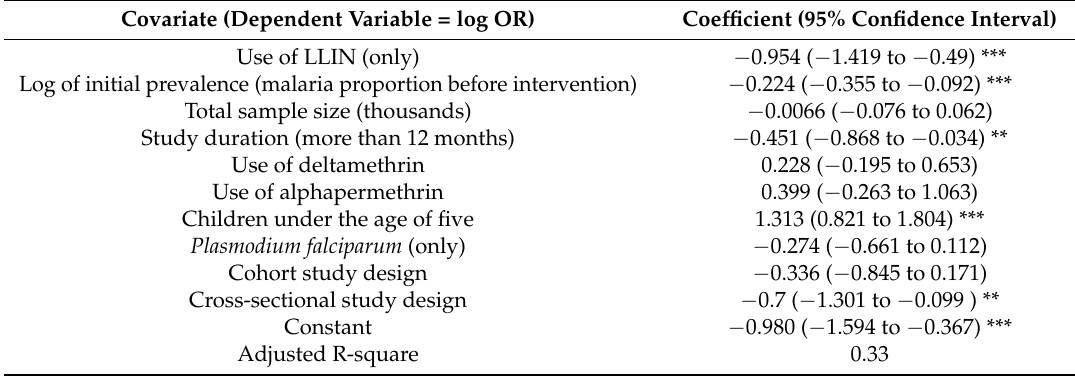
Table 2. Meta-regression results ( n = 154) of a reduction in malaria prevalence by LLIN/ITN. Covariate (Dependent Variable = log